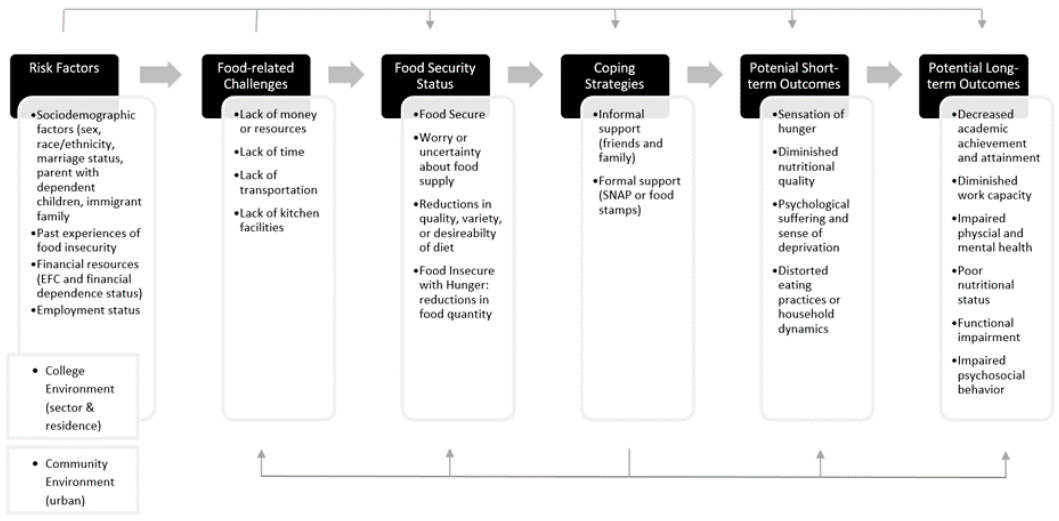
Figure 1. Conceptual Model of Food Insecurity. Note: Adapted from Alaimo (2005) for the college